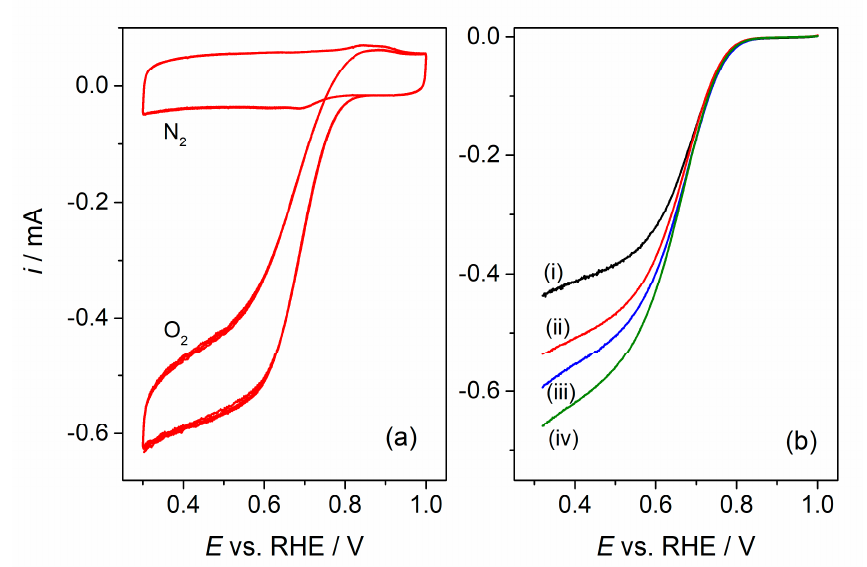
Figure 2. ( a ) Cyclic voltammograms of a GC/C-CuL rotating disk electrode (RDE) rotated at 900 rpm, in 0.1 M NaOH solution saturated with N 2 and O 2 . Scan rate: 0.05 V s − 1 . ( b ) Steady-state polarization curves measured by slow potentiodynamic scans (scan rate: 1 mV s − 1 ) on a GC/C-CuL RDE rotated at 400 (i), 900 (ii), 1200 (iii), and 1600 (iv) rpm, in 0.1 M NaOH solution saturated with O 2